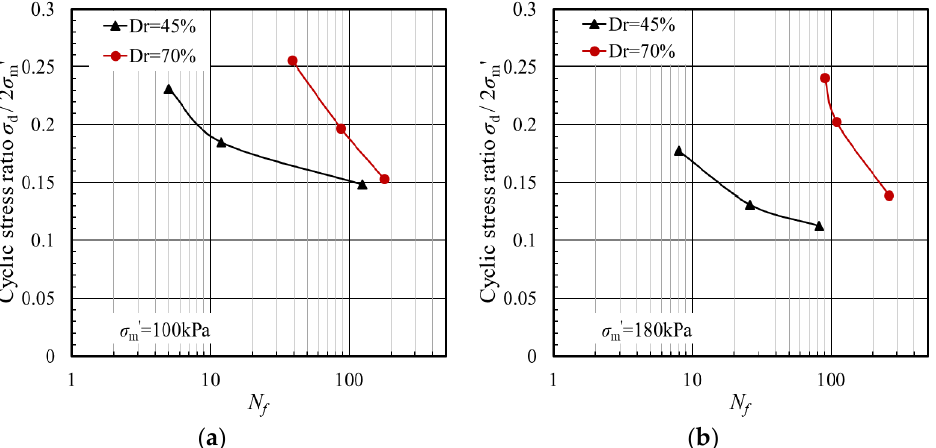
Figure 6. Cyclic strength curve of silty sand with different relative density: ( a ) σ m ’ = 100 kPa; ( b ) σ m ’ = 180 kPa.